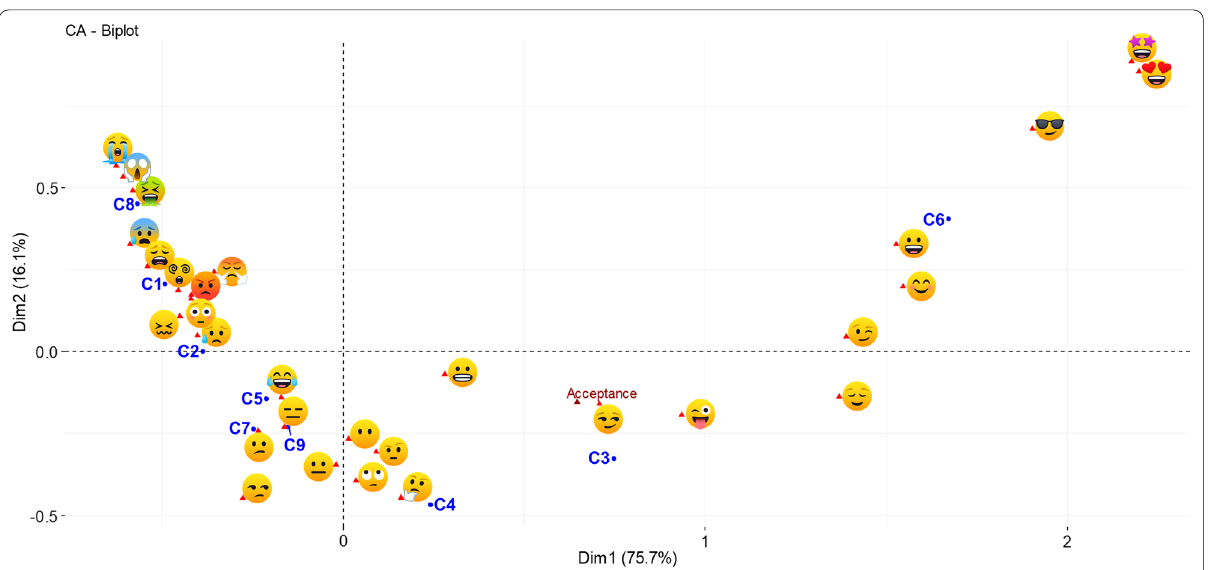
Fig. 3 Correspondence analysis symmetric plot. C1—crowding, C2—anterior open bite, C3—interincisal diastema, C4—increased overjet and deep bite (Class II division 1), C5—anterior crossbite (Class III), C6—ideal occlusion, C7—unilateral posterior crossbite, C8—anterior open bite plus bilateral posterior crossbite plus crowding, and C9—deep bite (Class II division